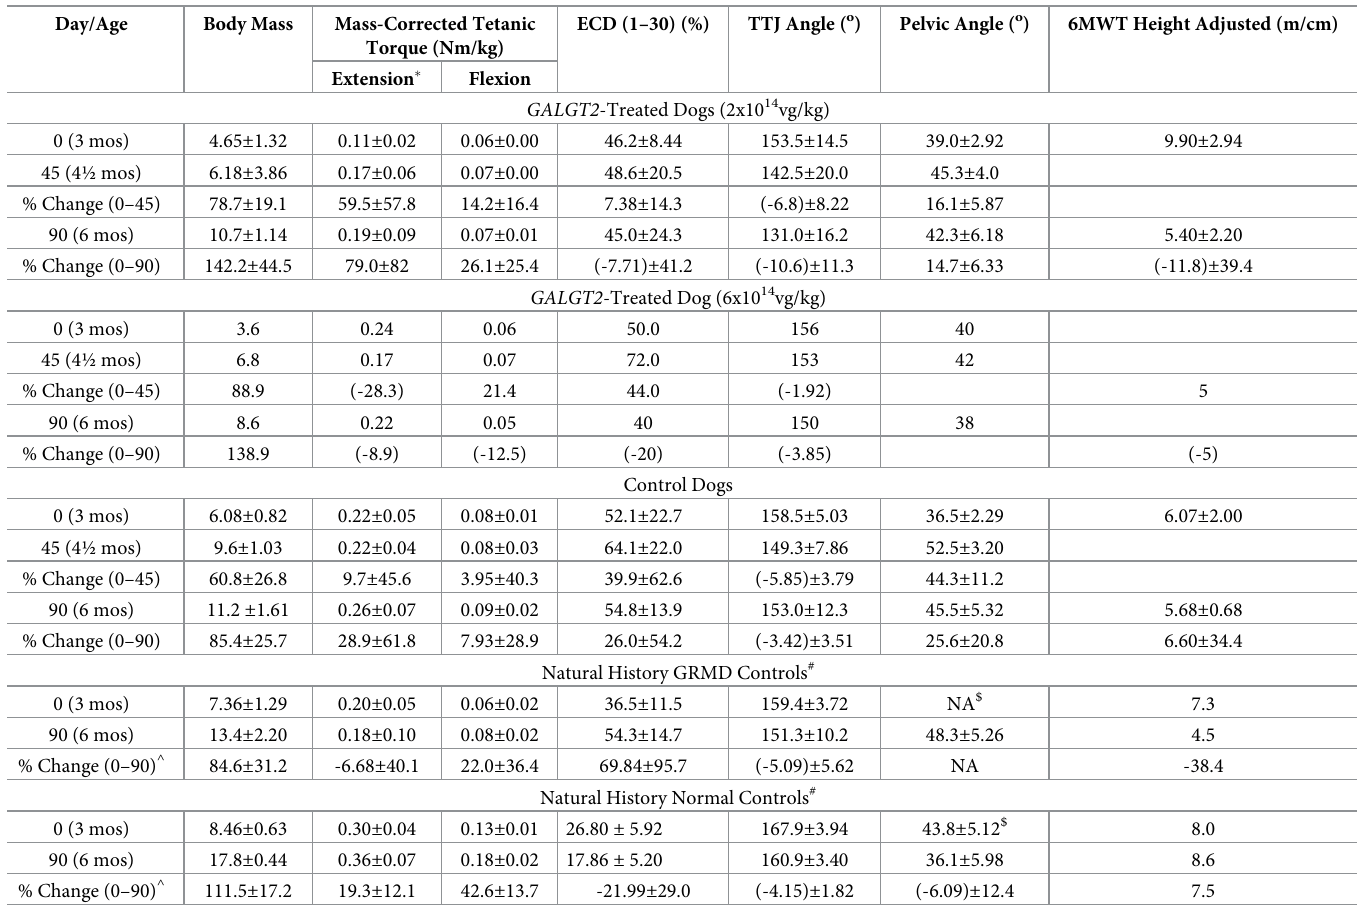
Table 1. Functional data from GRMD